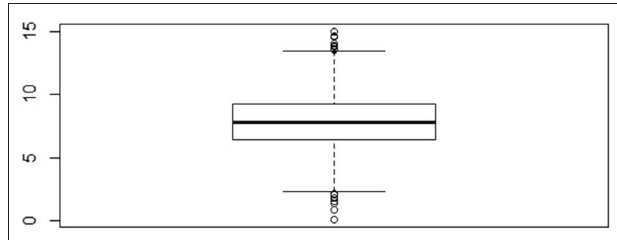
FIGURE 2 | Boxplot of the housing